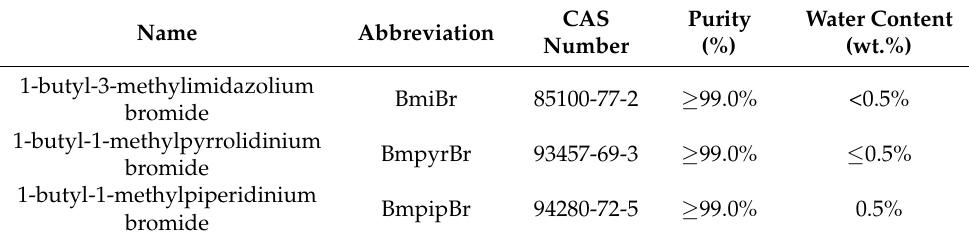
Table 1. Ionic liquids (ILs) with bromide anion used in the styrene–butadiene rubber (SBR)